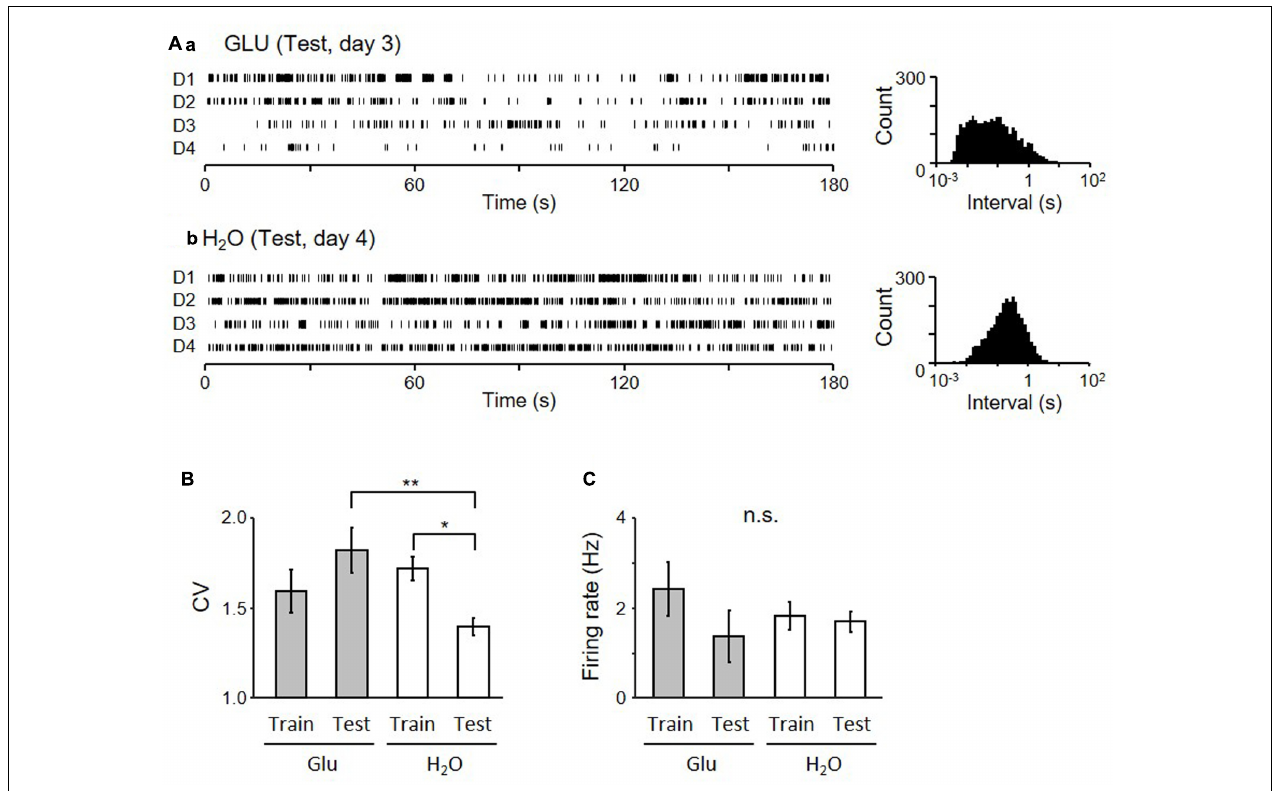
FIGURE 6 | Firing patterns of pMSNs in the dark period of the Test session. (A) Raster plots of neuronal activity of two neurons (a from GLU-group and b from H 2 O-group) in the dark-period of four cycles (D1–4) (left) and inter-spike interval histograms of the given neurons (right). (B) Comparison of coefficient of variance (CV) of the inter-spike intervals of all neurons recorded during the 4 days of each session in each group. ∗ p < 0.05, ∗∗ p < 0.01. (C) Comparison of mean firing rates.